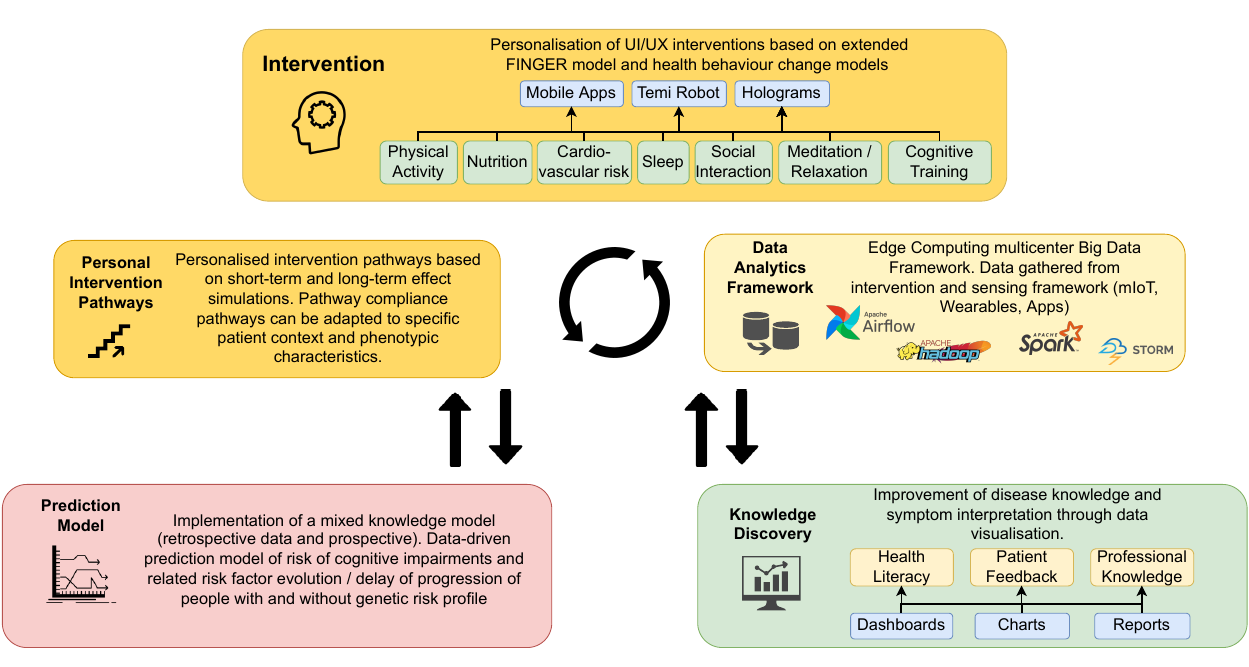
Figure 1. The LETHE overall